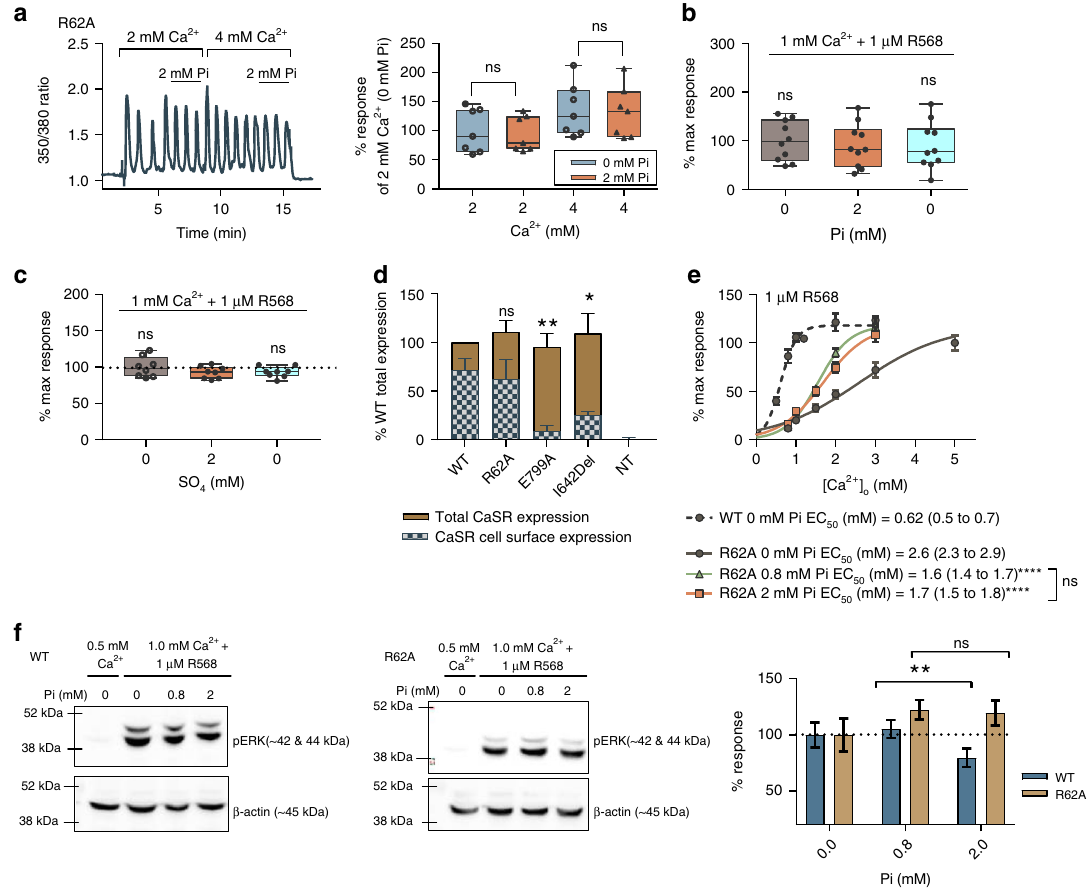
Fig. 7 CaSR R 62 A is not inhibited by Pi. CaSR R 62 A -induced Ca 2 þ i -mobilization is not sensitive to Pi upon stimulation with Ca 2 + ( a , n = 7), or cotreatment with R568 ( b , n = 10). c CaSR R 62 A -induced Ca 2 þ i -mobilization is also insensitive to SO 4 ( n = 8). a – c Area under the curve was calculated for each treatment and normalized against maximal response. d Cell surface expression levels of CaSR WT , CaSR R 62 A , and known defective mutants measured in transiently transfected HEK cells with non-transfected HEK-293 cells (NT) used as negative controls ( n = 9, performed in triplicate; NT, n = 6). Data normalized to CaSR WT (WT) total expression levels. e Ca 2 + concentration − effect curves for Ca 2 þ i -mobilization on CaSR R 62 A (with 0, 0.8, or 2 mM Pi) and CaSR WT (without Pi, shown here for comparison purposes). Data fi tted to a four-parameter Hill equation (Eq. (1)) for sigmoidal concentration − response variable slope ( n = 8 – 10, from three independent experiments). Data fi tted best when EC 50 (shown as mean with 95% con fi dence interval) values for Ca 2 þ o were different among data sets and E max was shared, P < 0.01 extra sum-of-square F- test. f Representative immunoblot showing pERK responses by CaSR R 62 A and CaSR WT after a 10-min stimulation; 0.5 mM Ca 2 + used as negative control. Changes in pERK were corrected for β -actin abundance and then normalized to the Pi-free stimulated control ( n = 8, from four independent experiments). Data are plotted as %mean ± SEM and analyzed by using RM- ANOVA, Dunnett ’ s multiple comparisons ( b – e ), or unpaired t test ( a , f ). ns not signi fi cant, * P < 0.05 and ** P < 0.01. Source data are provided as a